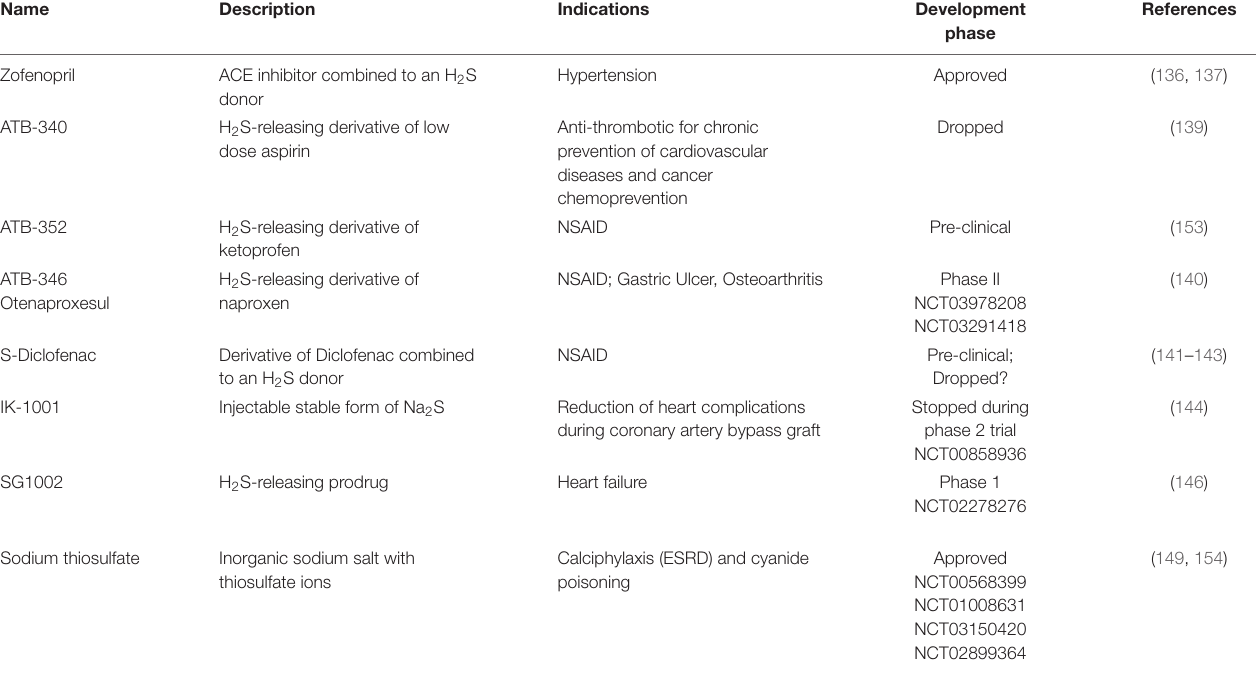
TABLE 1 | Clinical development of H 2 S-releasing